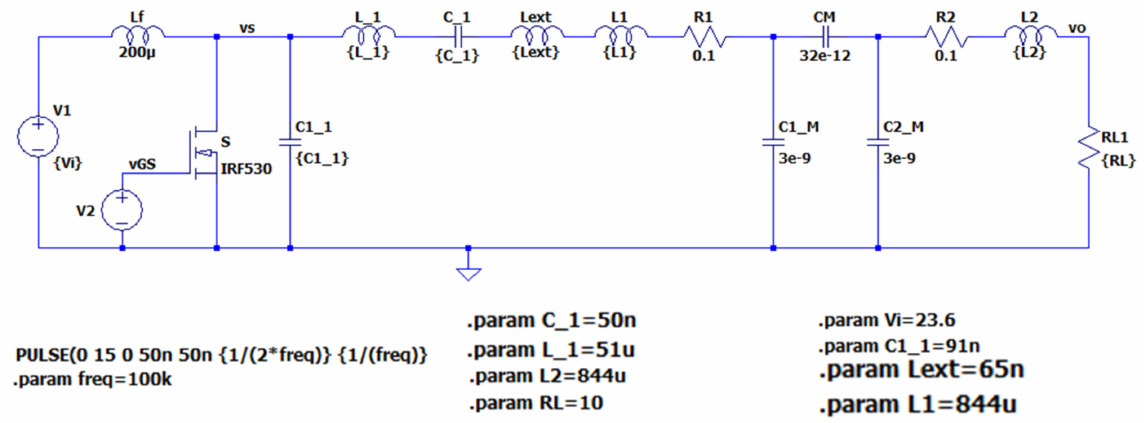
Figure 10. LTSpice circuit schematic.